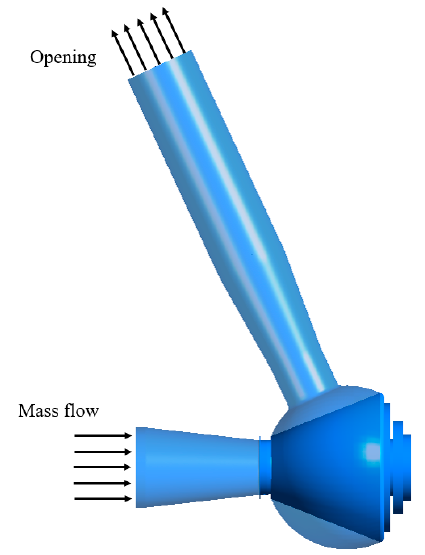
Figure 4. Boundary conditions of boiler circulating